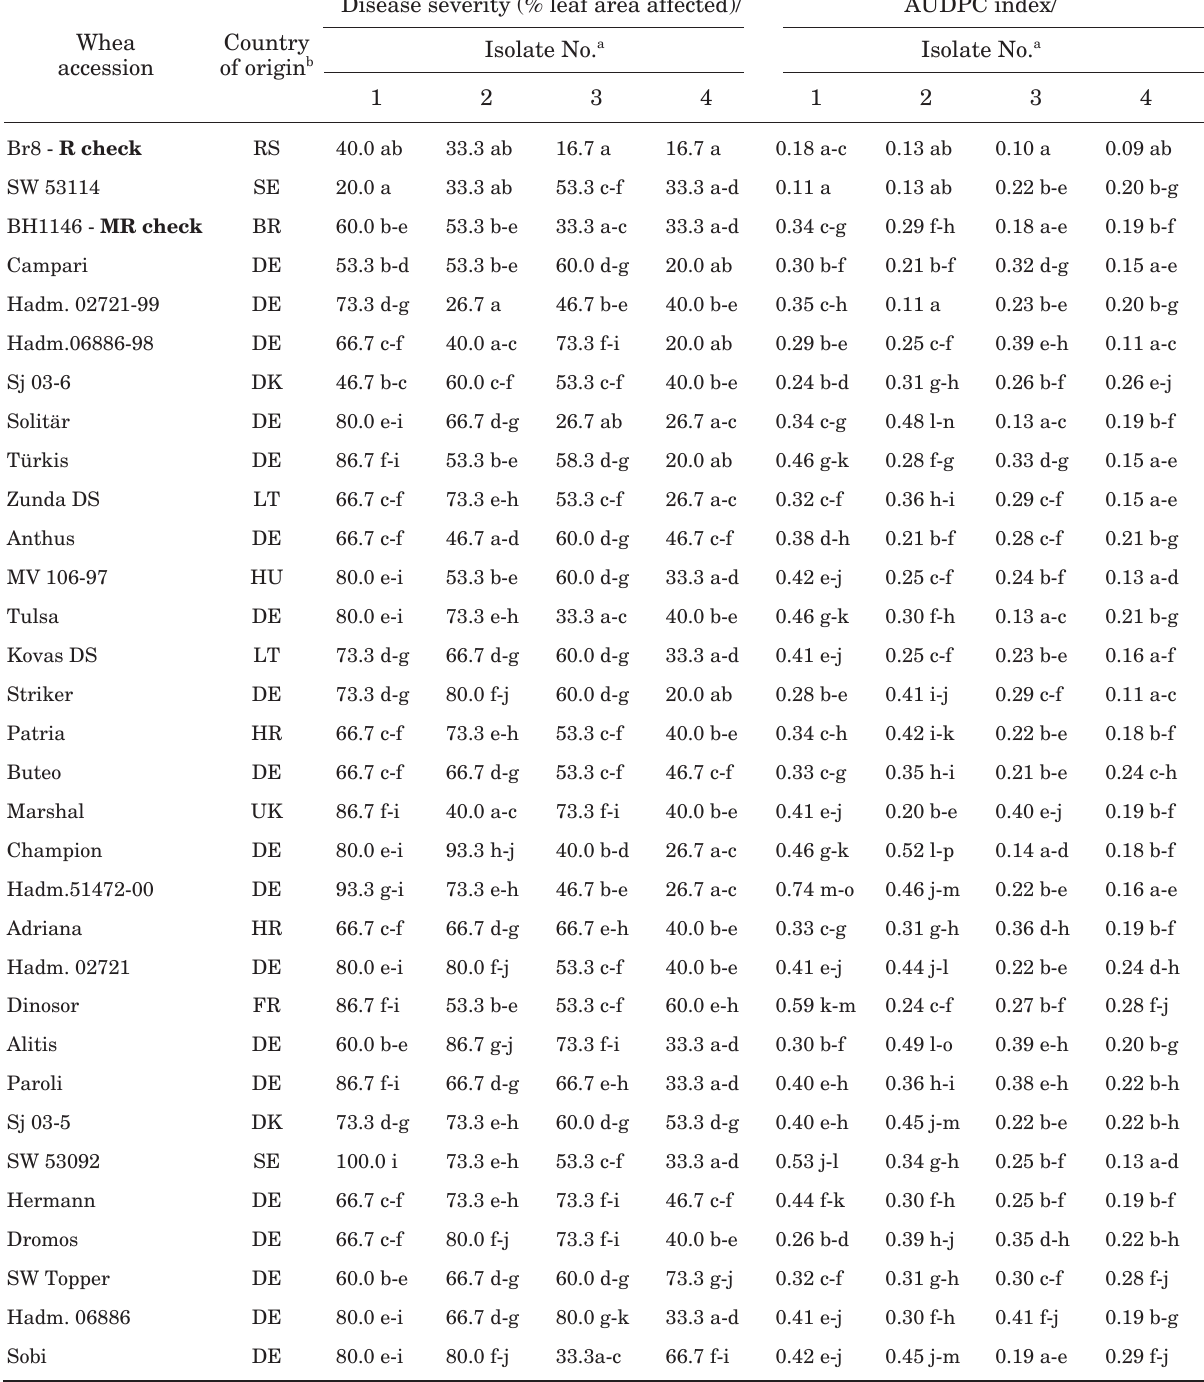
Table 1. Wheat accessions, countries of origin, disease severities and AUDPC indices for four isolates of Bipolaris sorokiniana. The Resistant, Moderatly Resistan and Susceptible checks are shown in